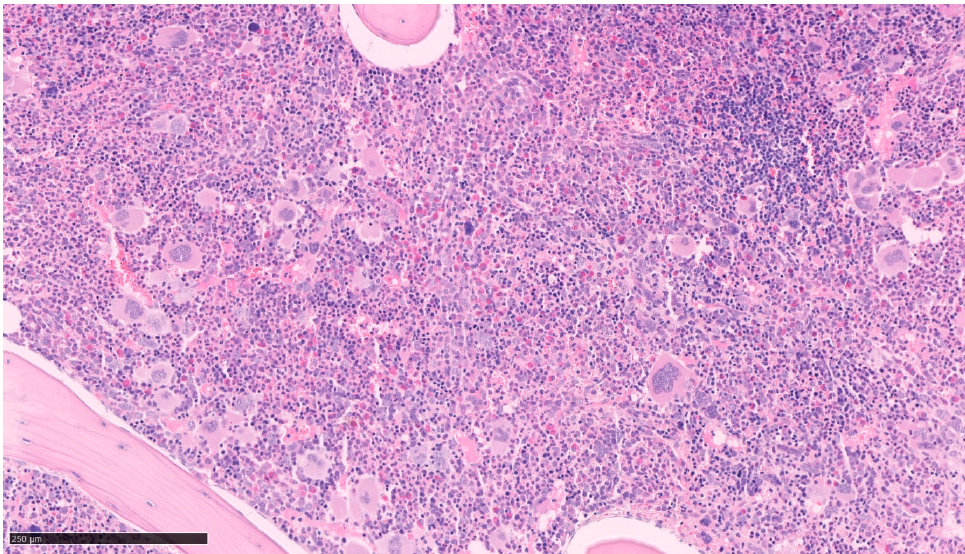
Figure 1. Bone marrow biopsy of Polycythemia Vera. Panmyelosis with an increase in pleomorphic mature megakaryocytes. (optical microscopy, May Grünwald Giemsa (MGG), low magnification ×15).